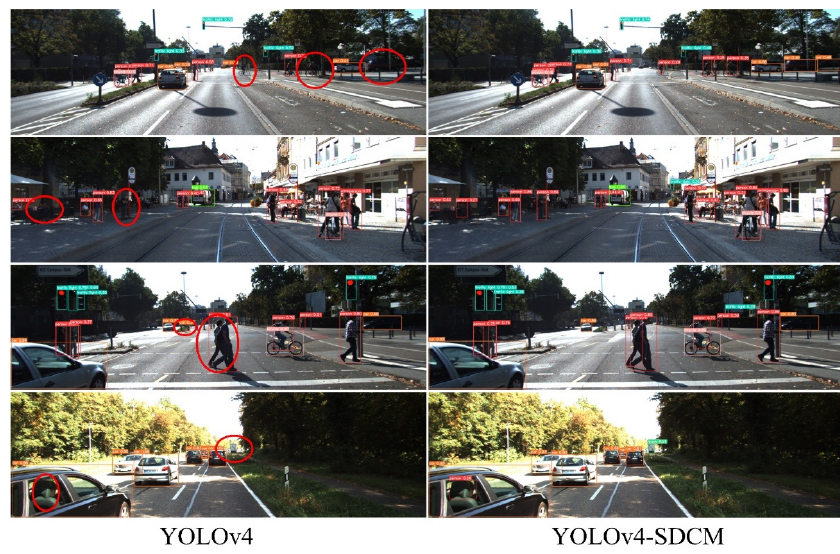
10 of 17 Table 2. Object detection accuracy comparison of Faster R-CNN, YOLOv4 and YOLOv4-SDCM on BDD100K data sets.